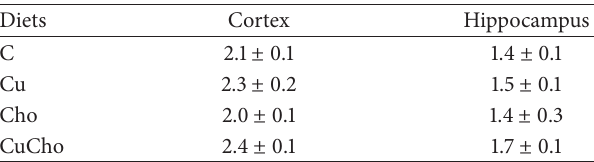
1.4 ± 0.3 Data were obtained as described in Section 2.12. They correspond to the mean of 10 individual determinations assayed in triplicate ± SD. Differences statistically significant among the different diets are indicated with distinct superscript